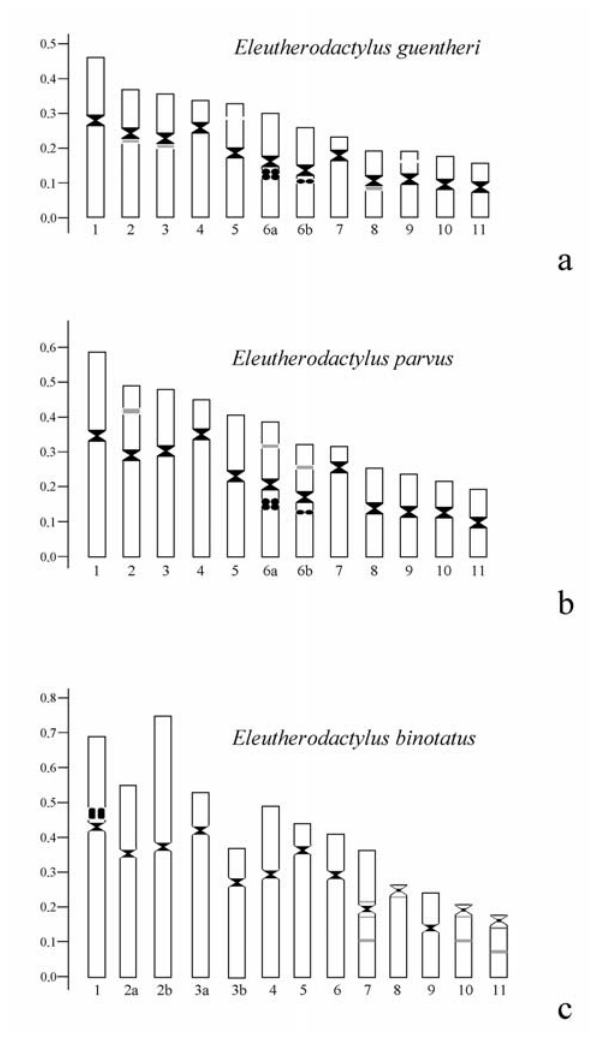
Figure 5 - Ideograms of the karyotypes of E. guentheri ( a ), E. parvus ( b ) and E. binotatus ( c ). Solid areas: dark C-bands. Gray areas: faint C-bands. Dark circles: NORs. Open regions: secondary constrictions. In c , the let- ters a and b indicate the different morphs of chromosomes 2 and